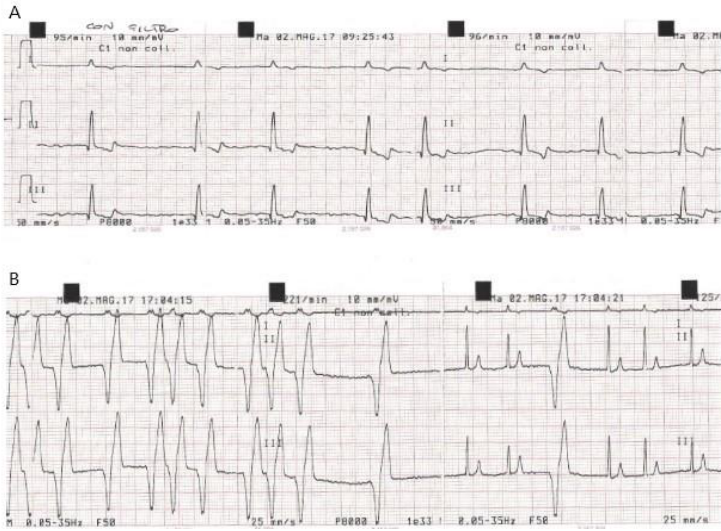
Figure 2. Dog C5 (Saint Bernard M, 6 years old). ( A ) ECG recorded at D0 before gene delivery procedure. (B) ECG recorded at 5 hours post procedure.